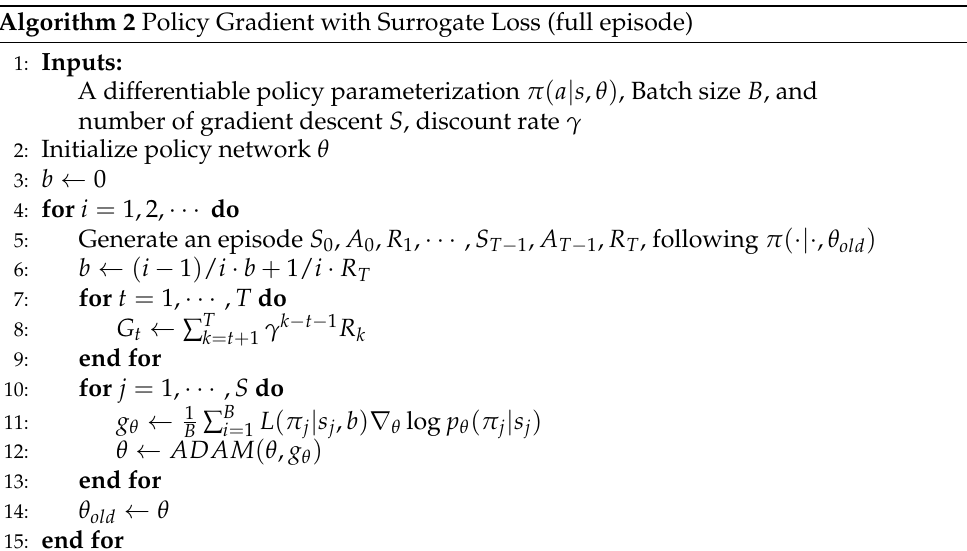
Algorithm 2 Policy Gradient with Surrogate Loss (full